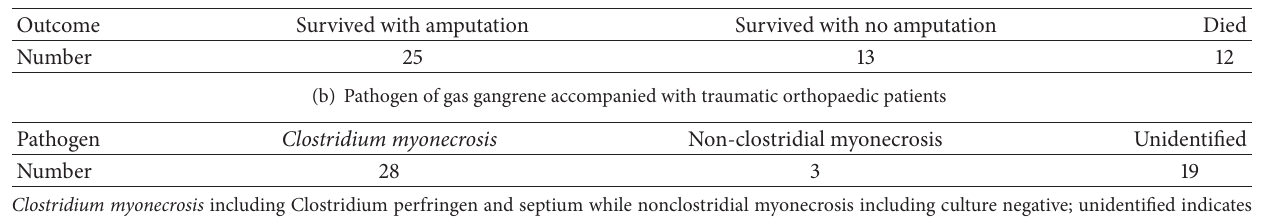
Table 2: Clinical outcome, pathogens, fractures locations, fractures, or surgeries types. (a) Clinical outcome after infection with gas gangrene